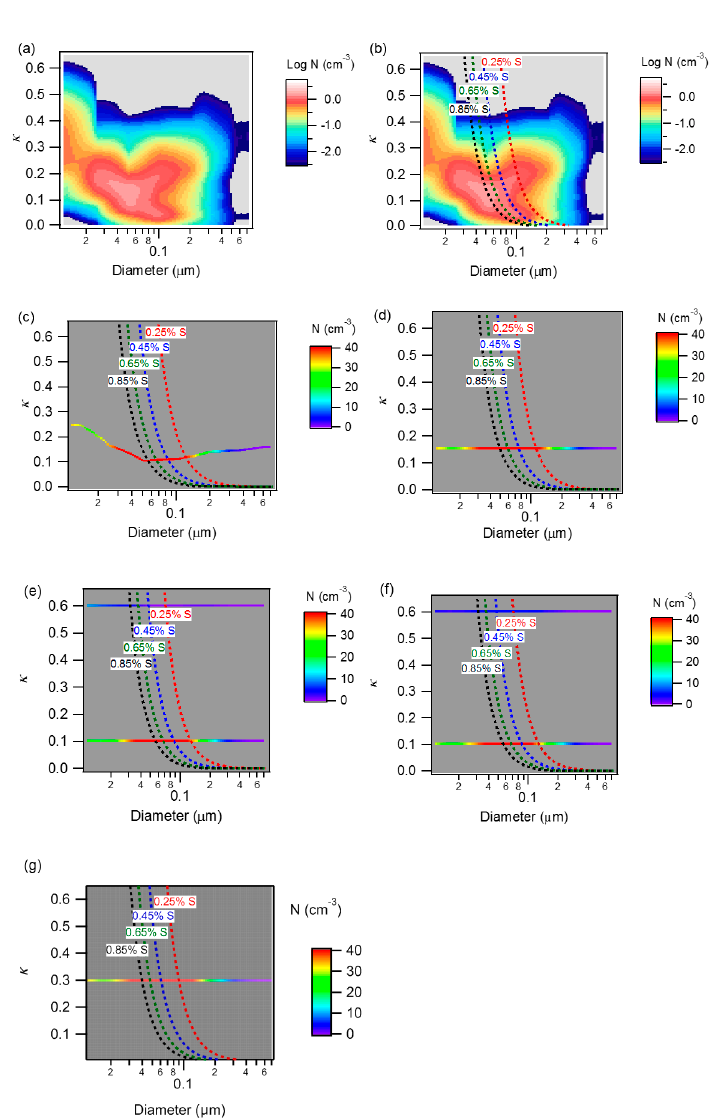
Figure 6. A graphical illustration of the approaches used to estimate N CCN . ( a ) Number concentration matrix calculated from a set of measured size and GF distributions. The size distribution is partitioned among the κ bins according to the GF distributions interpolated to each D p without any averaging or assumptions about mixing state or composition. The same matrix is shown in ( b ), with lines of constant S c added. As with all of the estimation techniques, N CCN (S) is estimated by summing the concentration elements (whole or part) above and to the right of the constant S c (= S) lines. The graphs in ( c – g ) are from the same set of size and GF distributions as those used for ( a , b ), but with various assumptions for mixing state and composition that collapse the κ distribution at each bin in the size distribution to one or two values. ( c ) internal mixture with κ (D d ), ( d ) internal mixture with κ ( ≠ D d ), ( e ) external mixture with κ (D d ), ( f ) external mixture with κ ( ≠ D d ), and ( g ) internal mixture with an assumed inorganic volume fraction of 0.5.